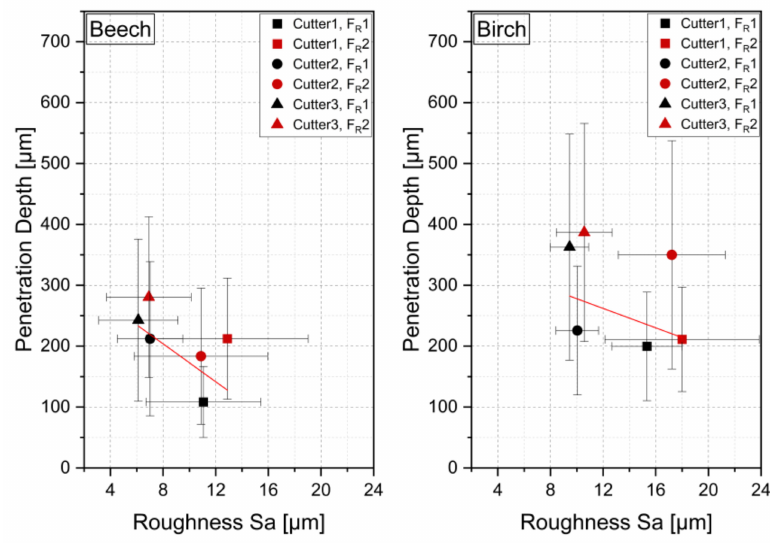
Figure 16. Interactions between penetration depth and roughness for different cutting combina- tions; the red line shows trendline, and error bars show standard deviation in x (roughness) and y (penetration depth) direction.